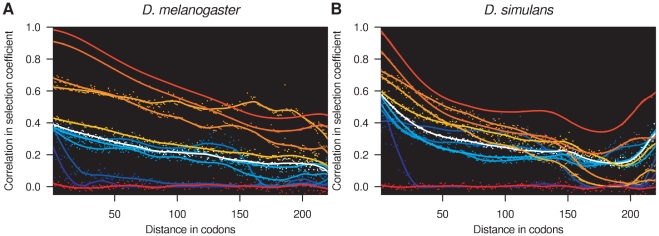
Spatial correlation in selection coefficients.Spacial correlation in selection coefficients in (A) D. melanogaster and (B) D. simulans. The correlation in the posterior probability of each selection coefficient is shown, calculated for all pairs of sites separated by the specified distance (circles). A smoothed estimate of the autocorrelation function has been superimposed (lines). The values of the selection coefficients are indicated by the coloring, which is the same as for Figure 1.